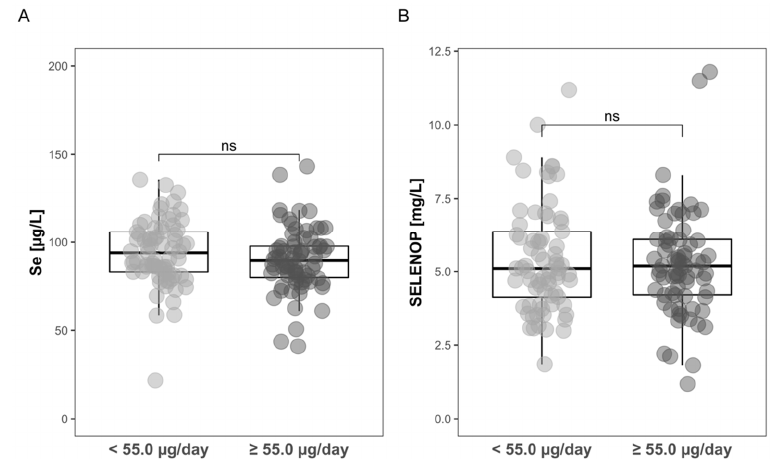
Figure 1. Comparison of calculated Se intakes per day as determined by the food recall method in combination with the food composition data in relation to the laboratory analysis of total Se and SELENOP concentrations measured in the plasma samples. No significant differences (“ns”) were detected between the two groups of different Se intakes (less or more than 55.0 µg Se/day) with respect to ( A ) total plasma Se, of ( B ) plasma SELENOP concentrations. Significance calculated by the Mann-Whitney U test, ns; p > 0.05.